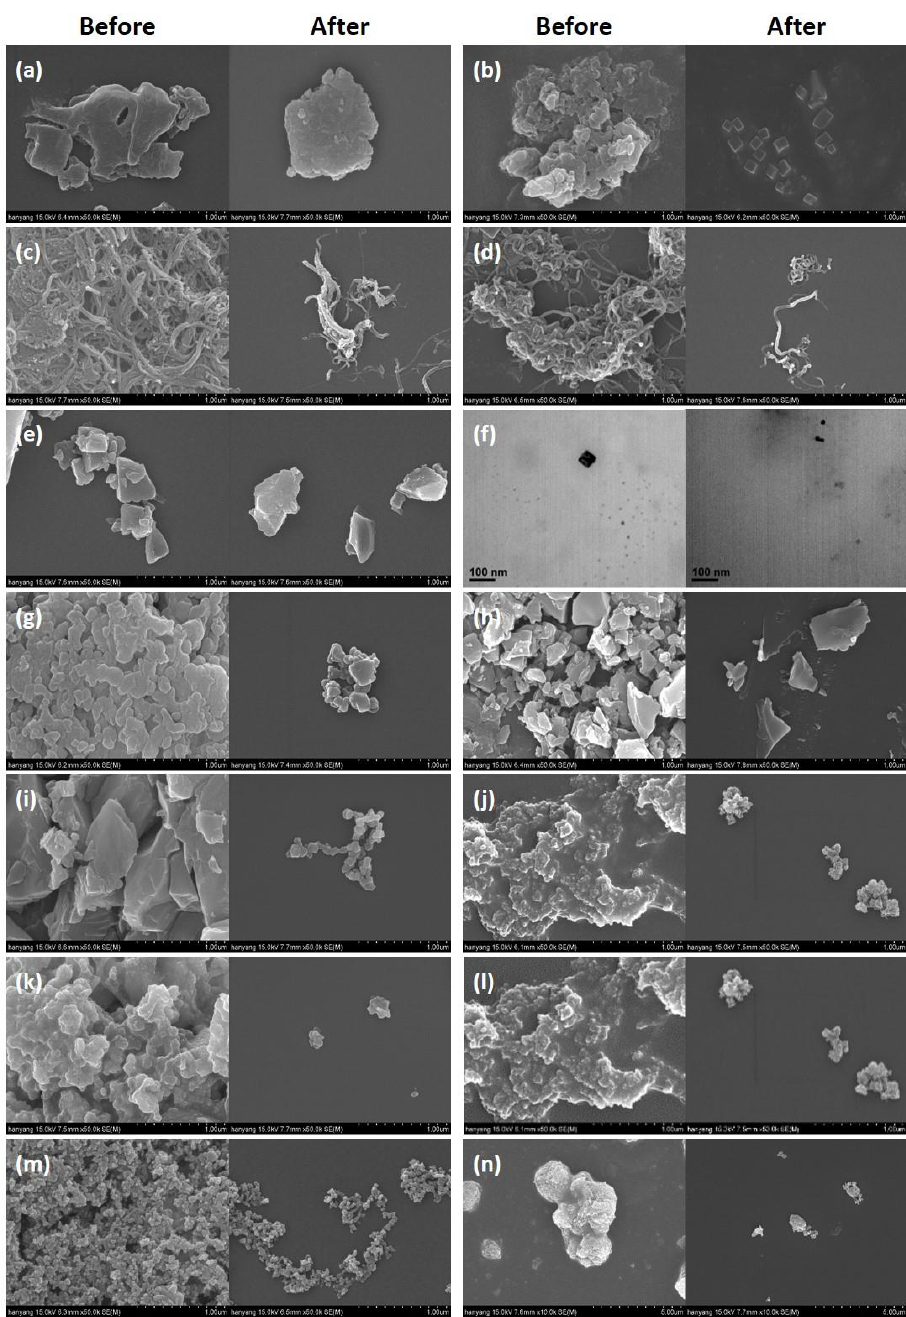
Figure 4. Microscopic images of manufactured nanomaterials before and after dispersion: ( a ) Al 2 O 3 , ( b ) carbon black, ( c ) SWCNTs, ( d ) MWCNTs, ( e ) CeO 2 , ( f ) dendrimers, ( g ) fullerene, ( h ) Au, ( i ) Fe, ( j ) nanoclays, ( k ) Ag, (l) SiO 2 , ( m ) TiO 2 , and ( n ) ZnO.